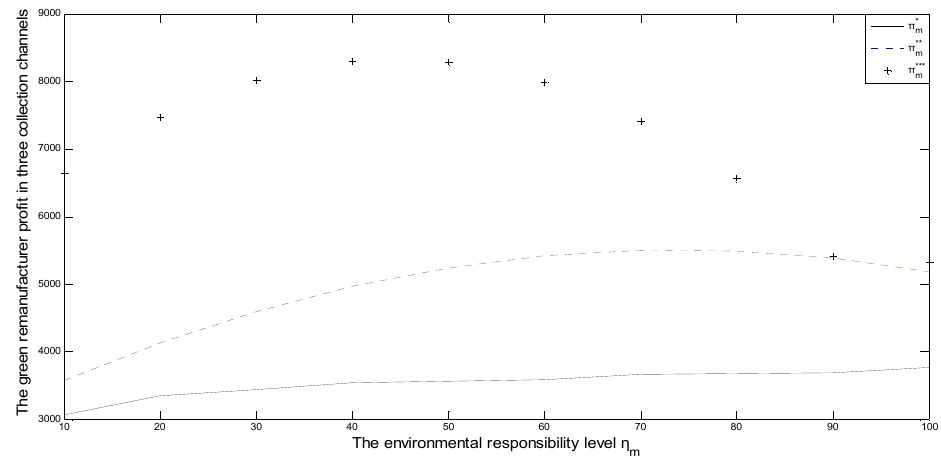
η on the green remanufacturer’s profit m